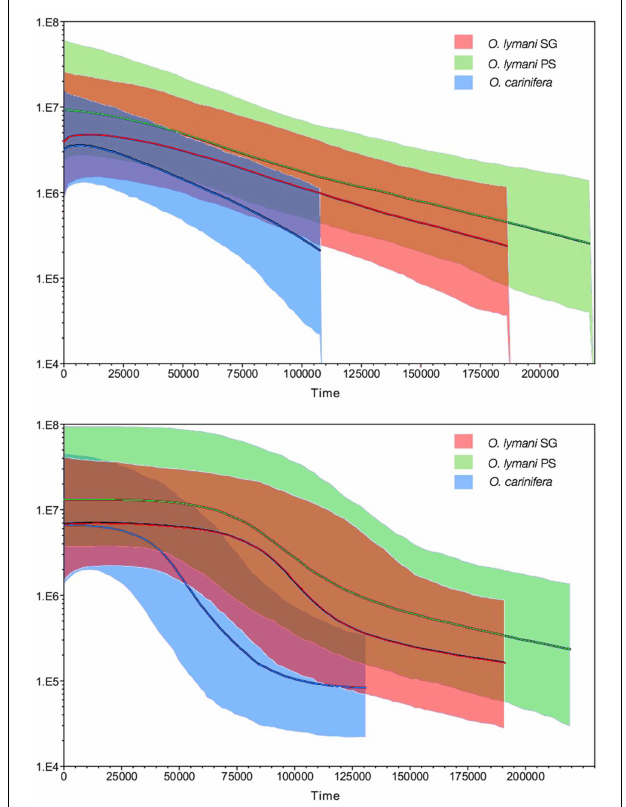
FIGURE 4 | Bayesian SkyRide (top) and SkyLine (bottom) plots indicating change in population size over time in O. carinifera (blue), O. lymani from the Patagonian Shelf (green) and the South Georgia shelf (red).